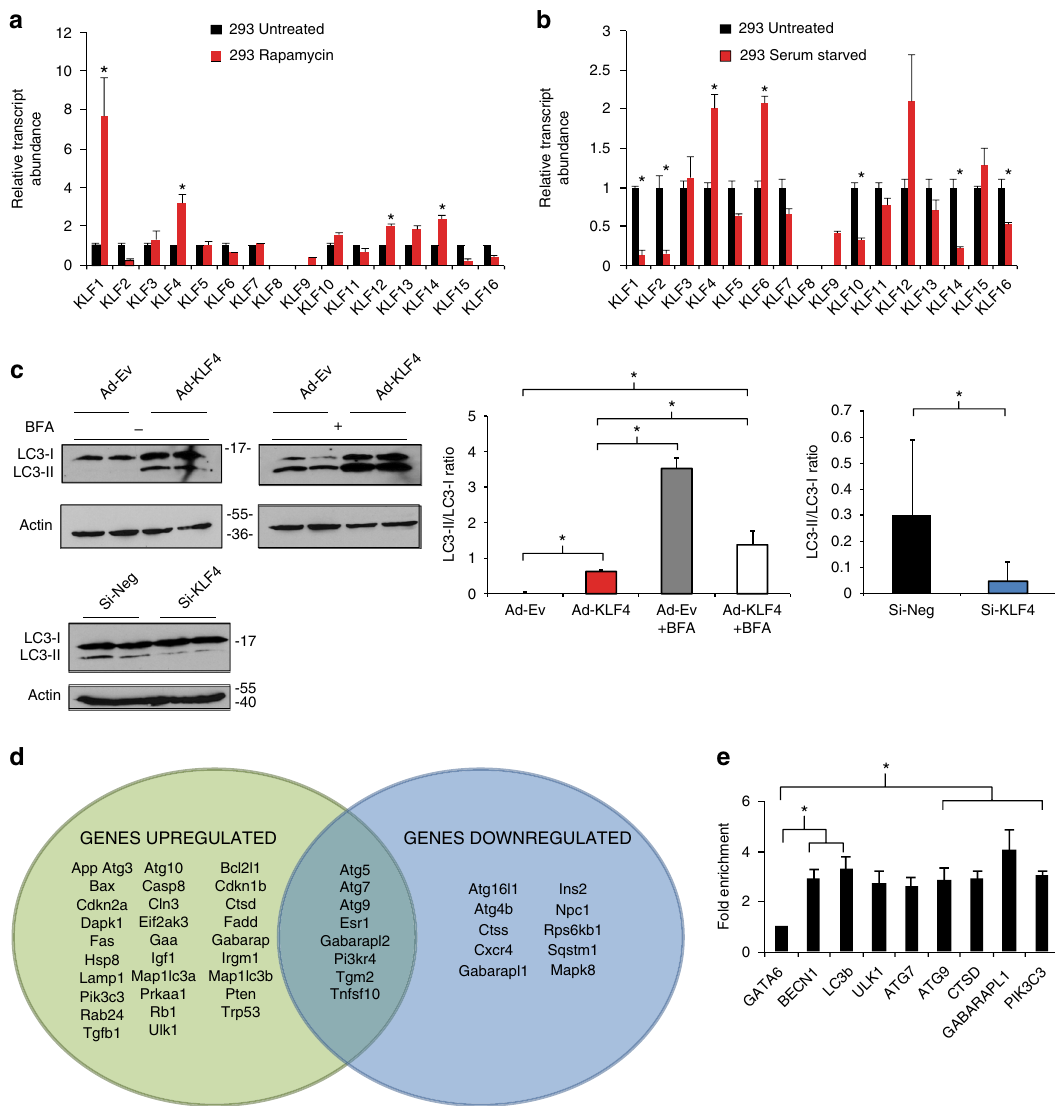
Fig. 4 KLF regulation of autophagy is conserved in mammalian cells. qPCR screens of HEK293 cells exposed to rapamycin treatment ( a ) and starvation ( b ). Cells were treated with respective regimen for 2 days prior to RNA isolation and qPCR analysis. Further details are given in Methods section. * P -value < 0.05 by Student ’ s T -test, N = 3 biological replicates. c Western blot analysis of LC3-I lipidation with and without KLF4 manipulation. Brie fl y, MEFs were treated with adenoviral Klf4 or siRNA targeting Klf4 and effects assessed by western blot 2 days afterwards. Data shown are representative of two independent experiments. Graphs represent quantitated LC3-II/LC3-I ratios. * P -value < 0.05 by Student ’ s T -test or after one-way analysis of variance followed by Tukey ’ s post hoc test. Further details in Methods section. d Autophagy pathway qPCR array analysis in MEFs with Ad-KLF4 or Si-KLF4 normalized to appropriate viral or siRNA control. MEFs were treated for 72 h prior to RNA isolation and qPCR analysis. Green oval represents signi fi cantly induced genes by Ad-KLF4 and blue oval represents genes reduced by Si-KLF4. P -value < 0.05 by Student ’ s T -test. N = 3 biological replicates. See also Supplementary Table 7 for full gene list of fold changes and P -values. e ChIP-qPCR in MEFs treated with control or adenoviral KLF4 of several target genes normalized to input DNA, then to nontarget control con fi rms KLF4 recruitment to CA/GCCC elements in regions upstream of autophagy genes. A locus upstream of GATA6 was used as a nontarget control. * P -value < 0.05 after one-way analysis of variance followed by the Dunnett ’ s post hoc test. N = 3 biological replicates. For list of ChIP-qPCR primers see Supplementary Table 9. All error bars represent standard error of the mean